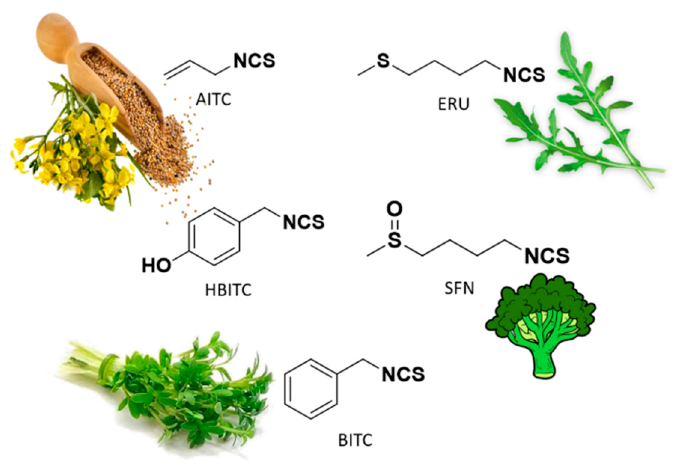
Figure 3. Chemical structures of natural isothiocyanates, which are abundant in cruciferous vegetables.